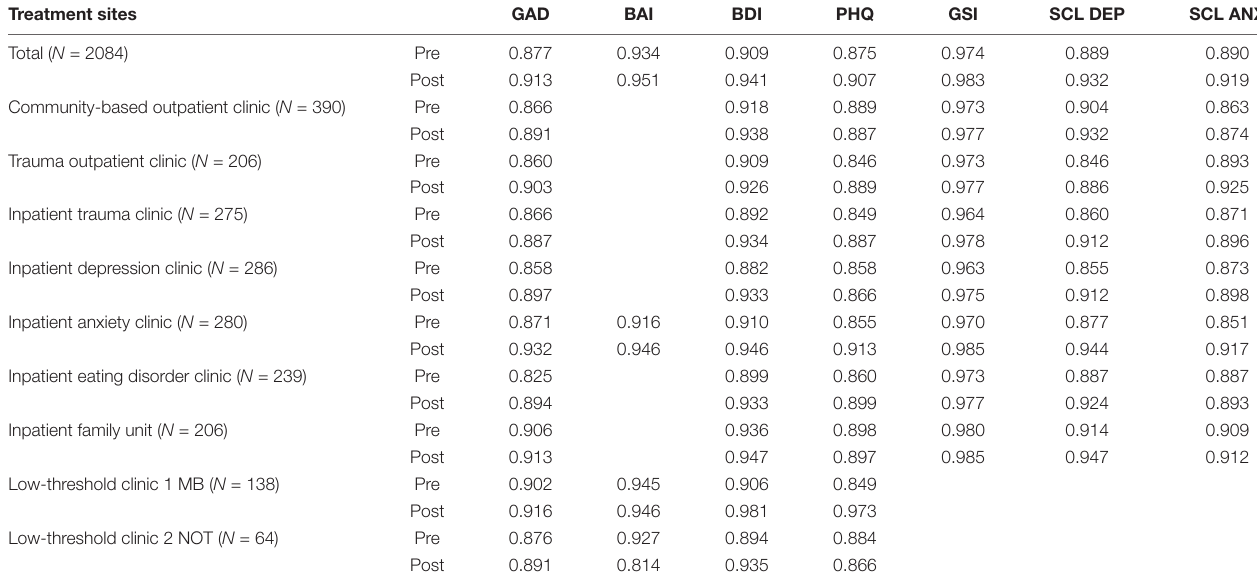
TABLE 1 | Cronbach’s alpha at pre- and post-treatment across different treatment sites. Treatment sites